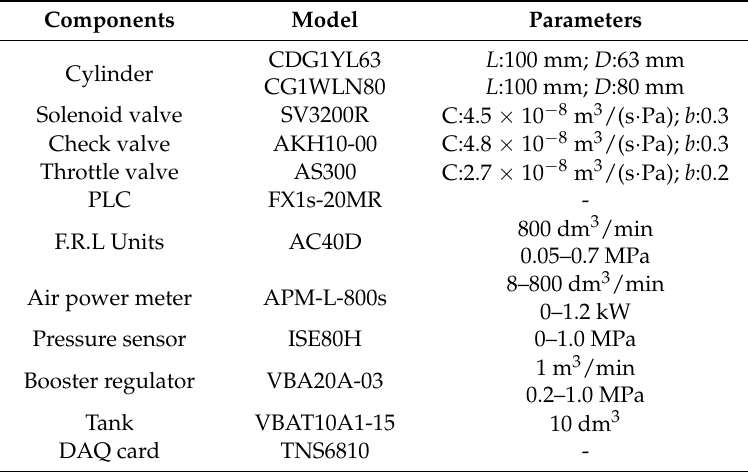
Table 1. Main equipment and their parameters.